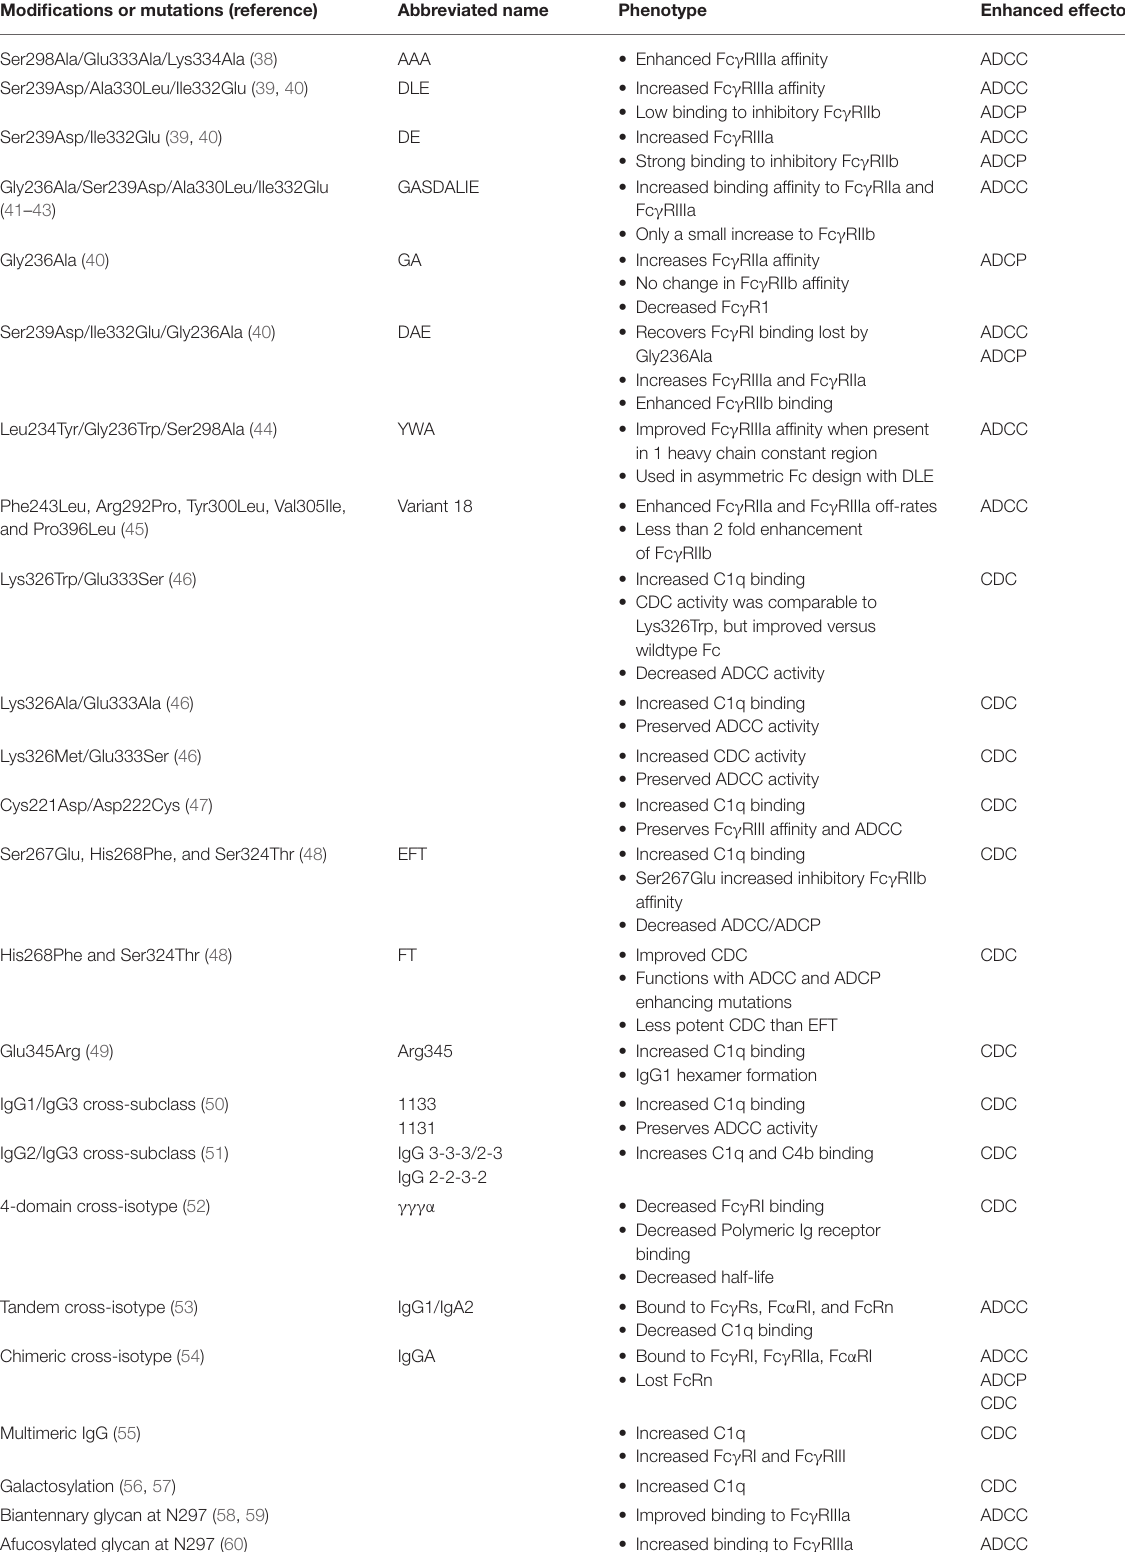
TABLE 1 | Fc modifications to enhance antibody effector